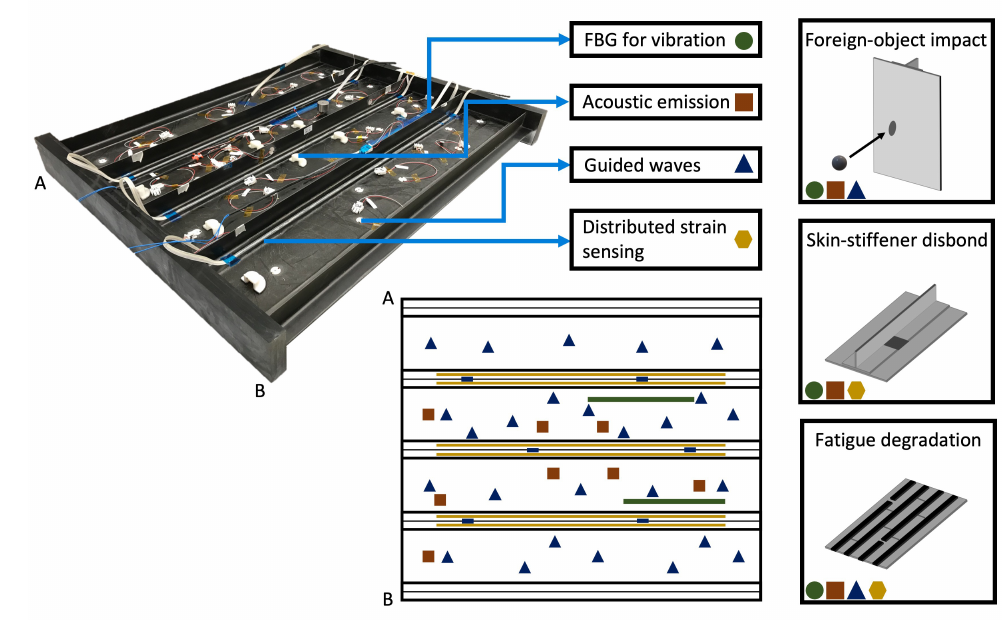
Figure 3. Multi-stiffener composite panel sensorized with multiple SHM techniques as part of a multi-sensor data-fusion-based framework for SHM of aircraft structures. The composite panel is a generic representation of a composite aircraft wing structure. The different SHM sensors are indicated in both the photo and the schematic of the composite panel using colors and symbols. Additionally, the critical in-service damages are displayed, where the symbols indicate which SHM technique is employed to monitor which